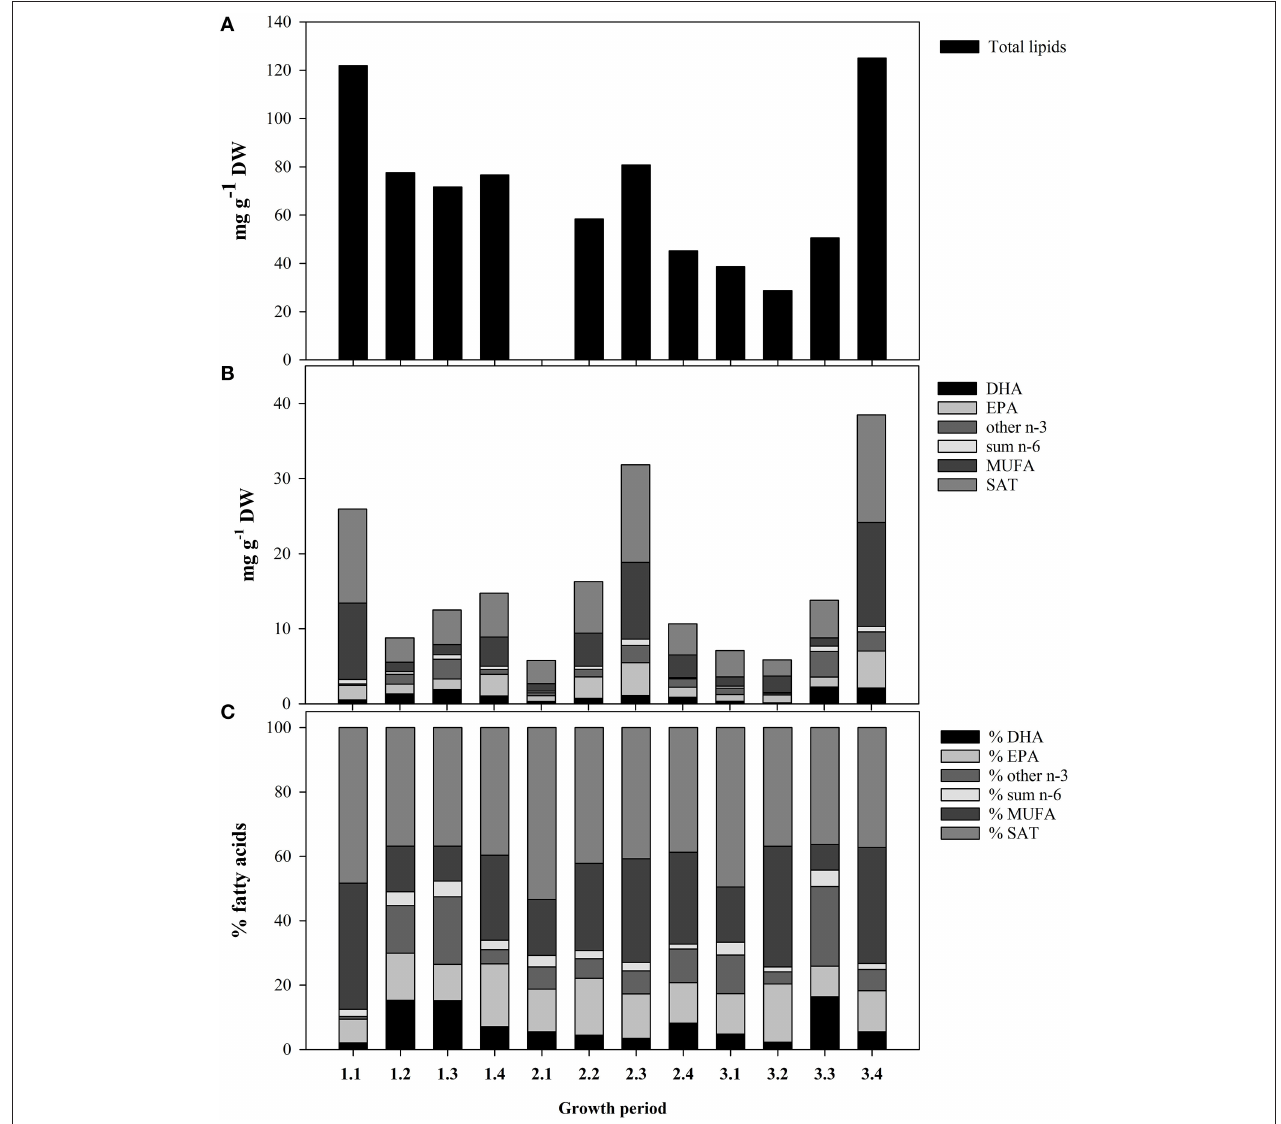
FIGURE 1 | Fatty acid profiles of the seston, < 55 µ m for the different growth periods listed in Table 2. (A) Total lipids content. (B) Quantitative content (mg g − 1 DW) of different groups of fatty acids. Important essential fatty acids (EFAs; DHA; and EPA) are separated. The total height of the bars represents the total fatty acid content. (C) Relative content of the different groups of fatty acids (% of total fatty acids).